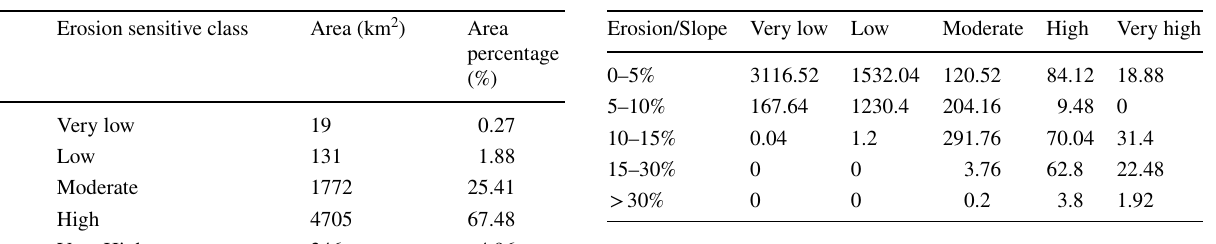
Table 7 Fuzzy membership value of soil erosion critical zone classes